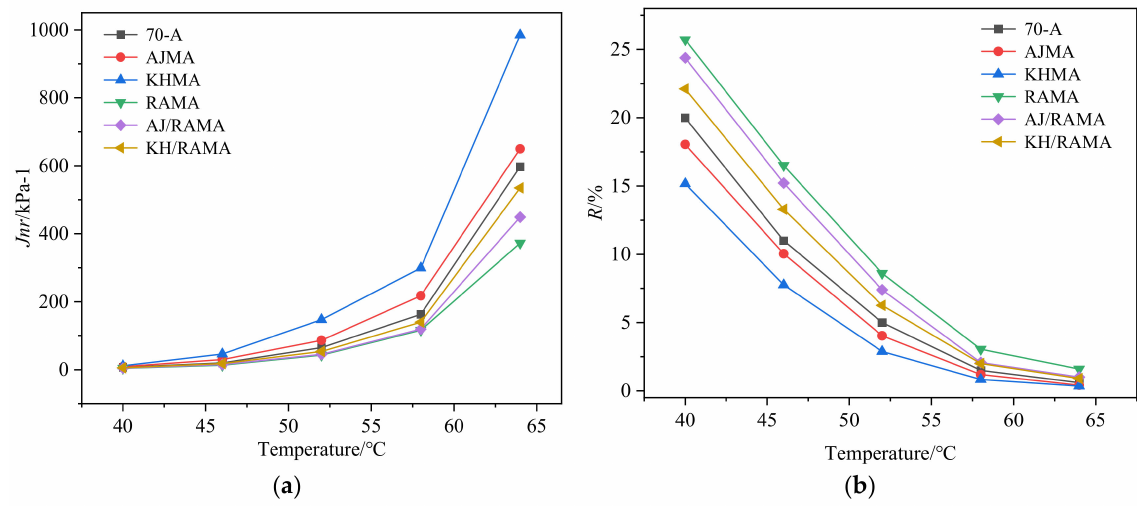
Figure 6. 3.2 kPa stress level: ( a ) Irrecoverable creep compliance; ( b ) Creep recovery rate.